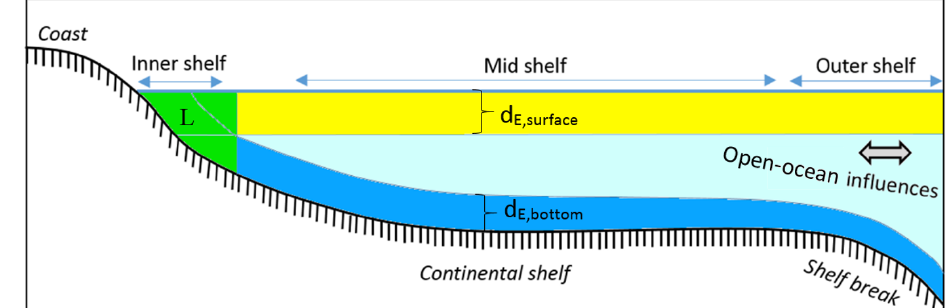
Figure 1. Schematic representation of different dynamic regimes on modern continental shelves. Influences by the adjacent open ocean are limited to the shelf-break region. The classical Ekman theory explaining wind-driven coastal upwelling is valid for the mid-shelf region where surface and bottom Ekman layers (marked by yellow and blue bands) are vertically separated. These frictional boundary layers interfere and partially or fully cancel out each other in shallow water, marked in green.